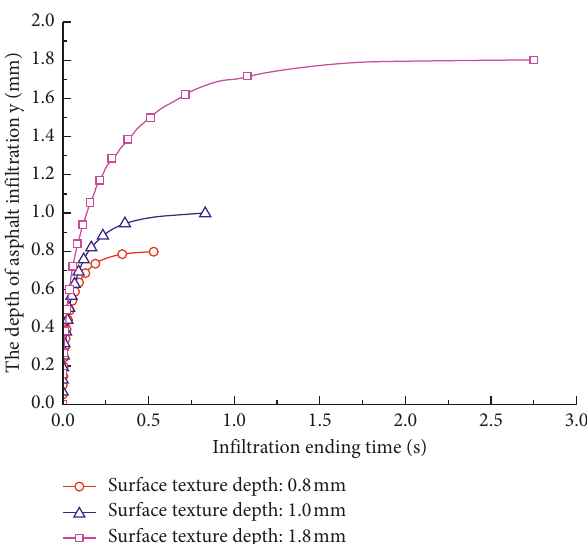
Figure 3: Infiltration curves of asphalt on the aggregate